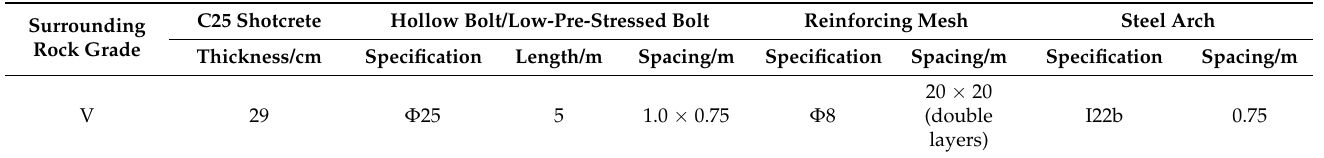
Figure 1. Geological section of the tunnel in the fracture zone. Table 1. Initial support parameters of the tunnel section.